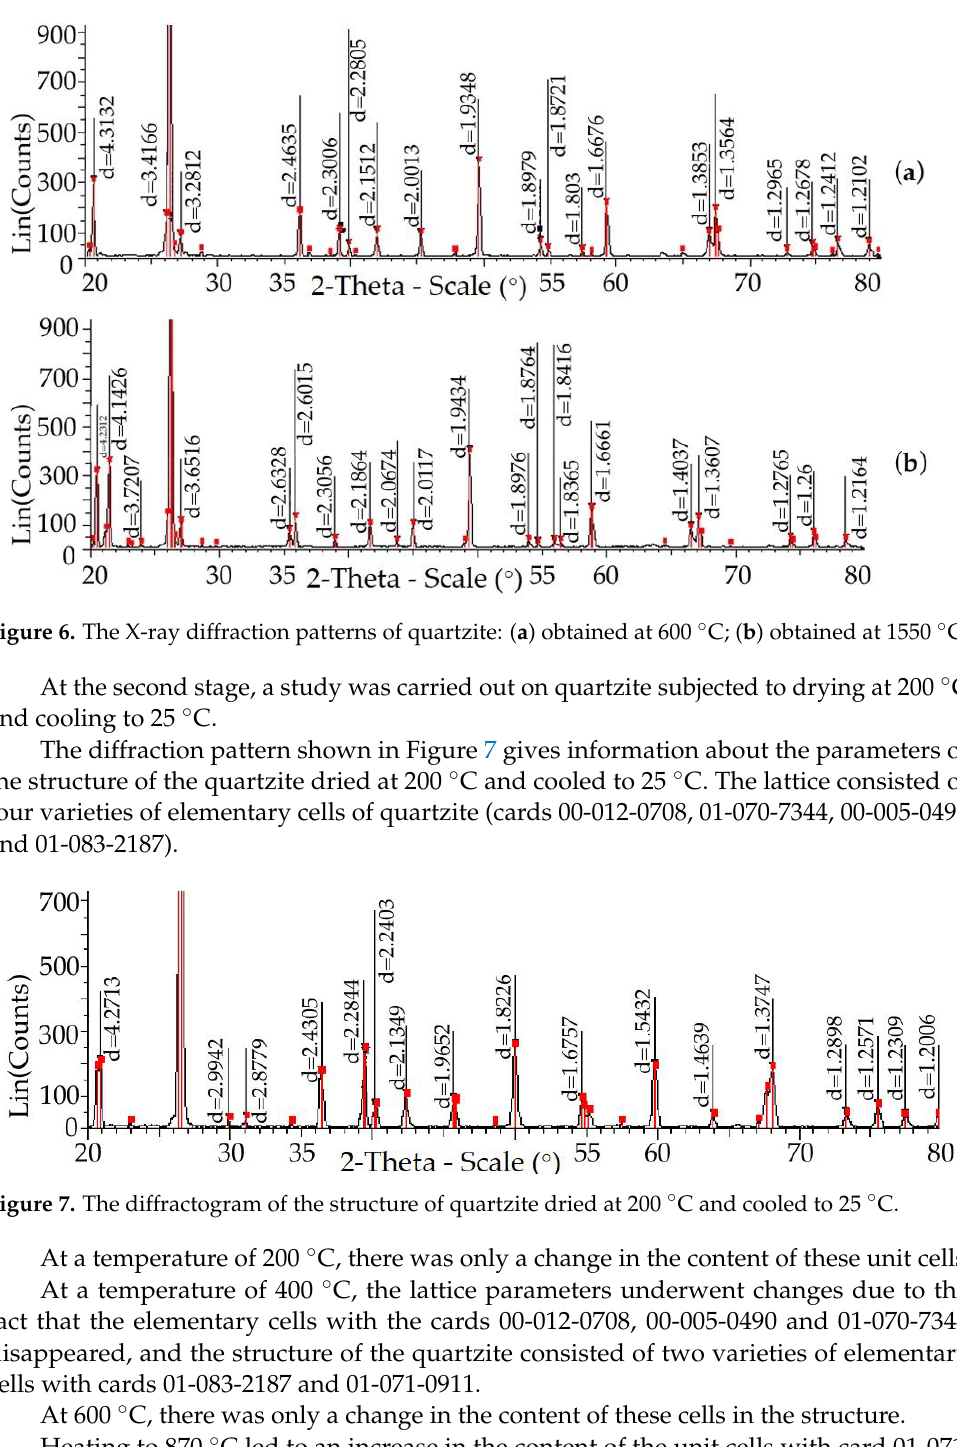
cells with cards 01-083-2187 and with cards 01-083-2187 and 01-071-0911.